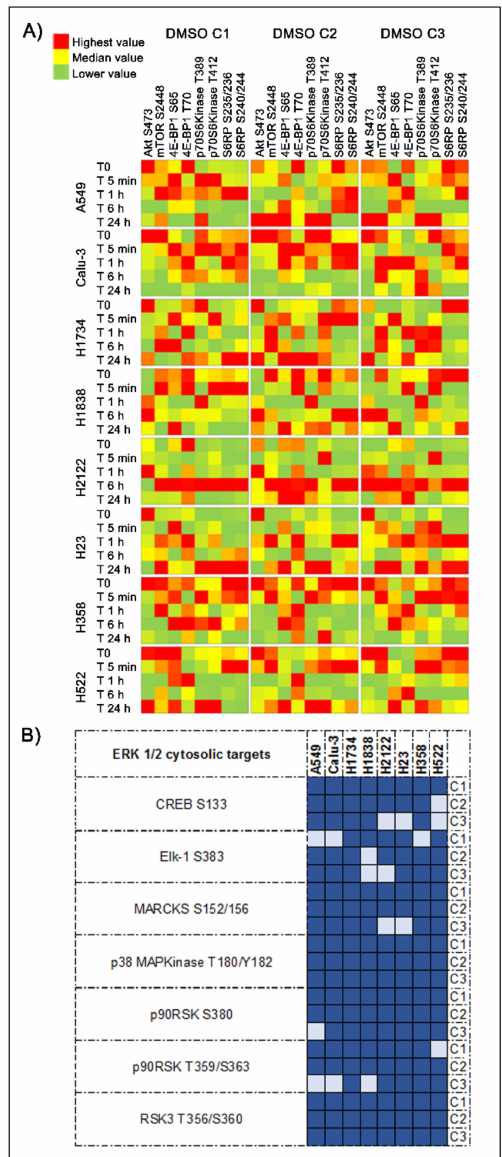
Figure 7. Changes in AKT-mTOR signaling and in the activation of ERK 1/2 downstream substrates induced by the DMSO. Heatmaps display average values ( n = 3) for proteins belonging to the AKT- mTOR signaling pathway across timepoints are shown using a red (highest) to green (lowest) scale (Panel A ). Matrixes illustrate the number of cell lines in which significant differences were detected (dark blue) in ERK 1/2 cytosolic targets and regulated transcription factors across the three DMSO concentrations. (Panel B